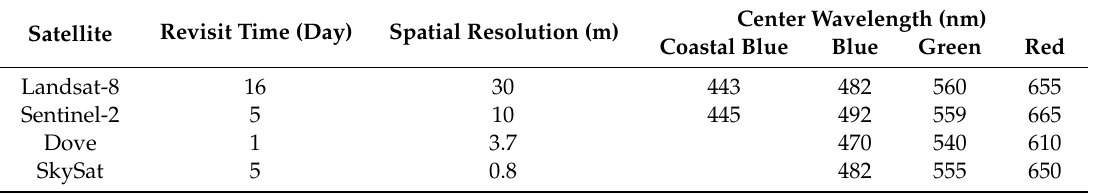
Table 1. Satellite parameters of selected satellite